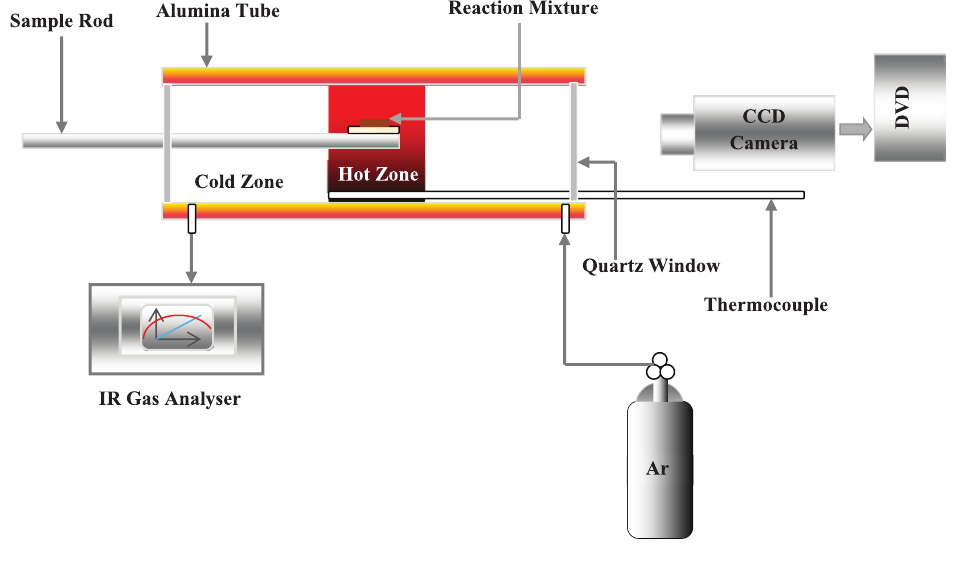
Fig. 3 : Schematic representation of the horizontal